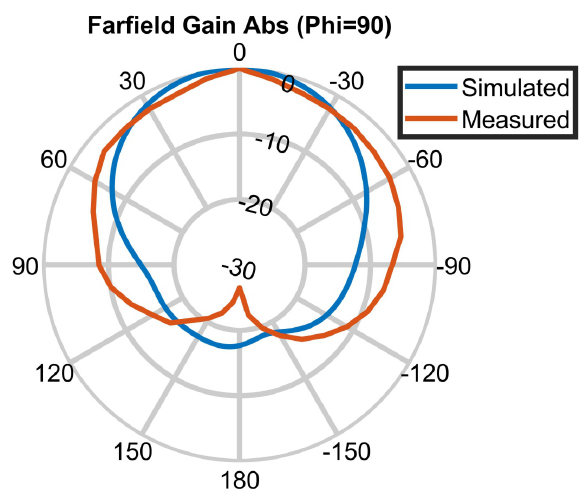
FIGURE 19. Simulated and measured normalized radiation patterns of the HGWMPA at 5.8 GHz (Phi=90 deg. plane).